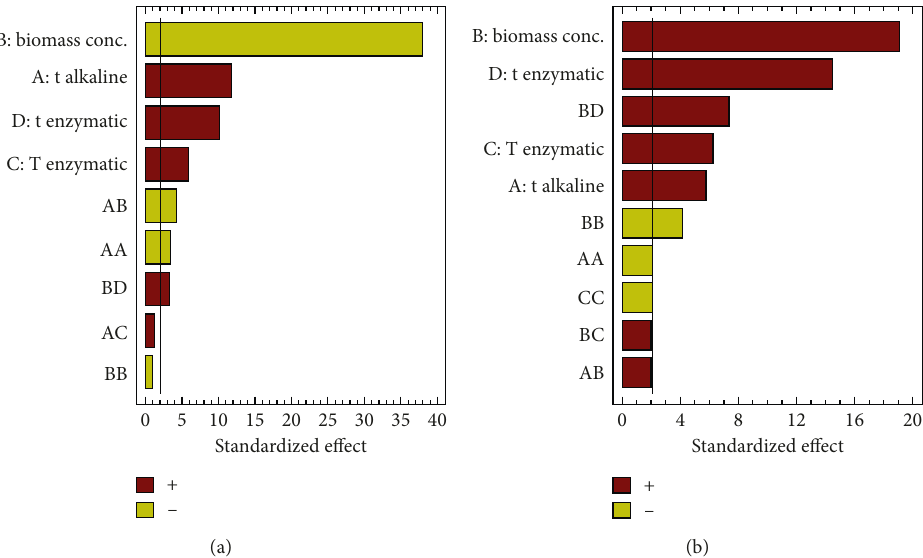
Figure 2: Pareto diagrams showing the standardized effects of the variables and interactions on the total extraction yield of (a) protein (% of total protein) and (b) FAN (% of total